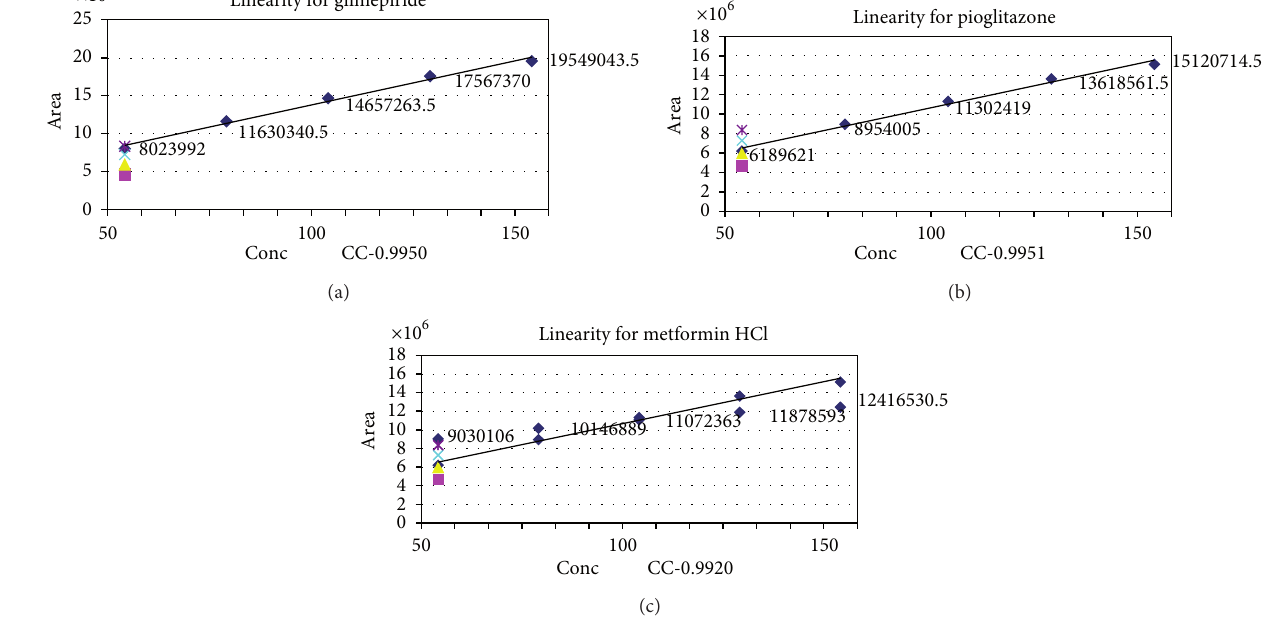
(c) F 5: Graphs for linearity of the